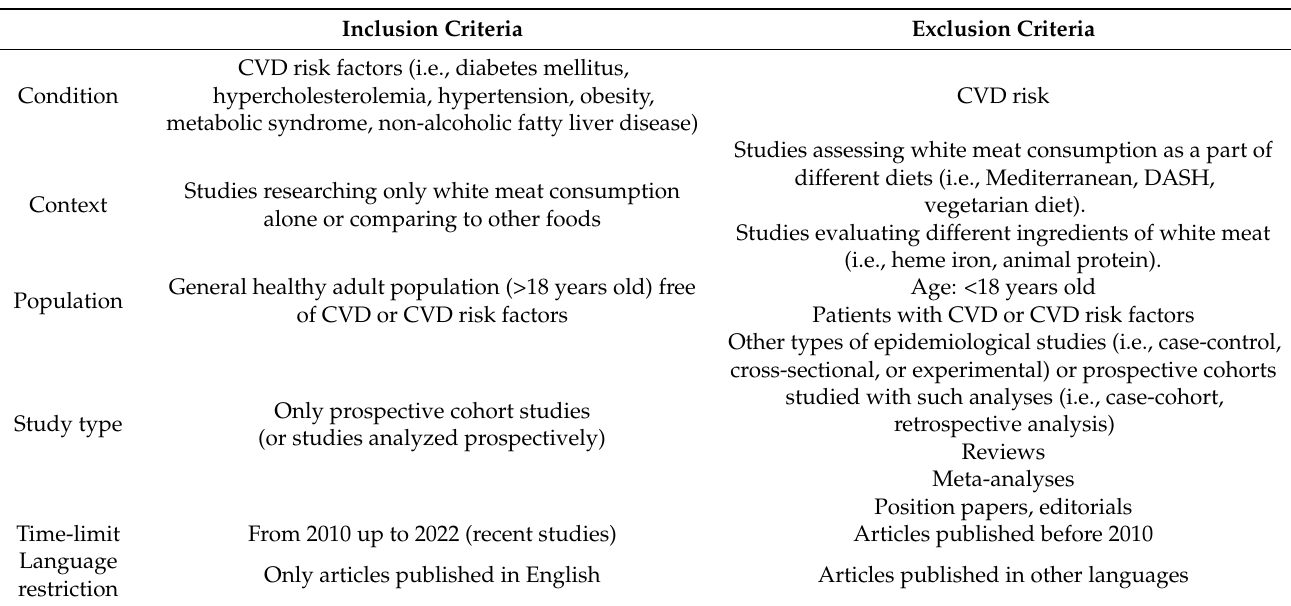
Table 1. Inclusion and exclusion criteria of this review according to the CoCoPop